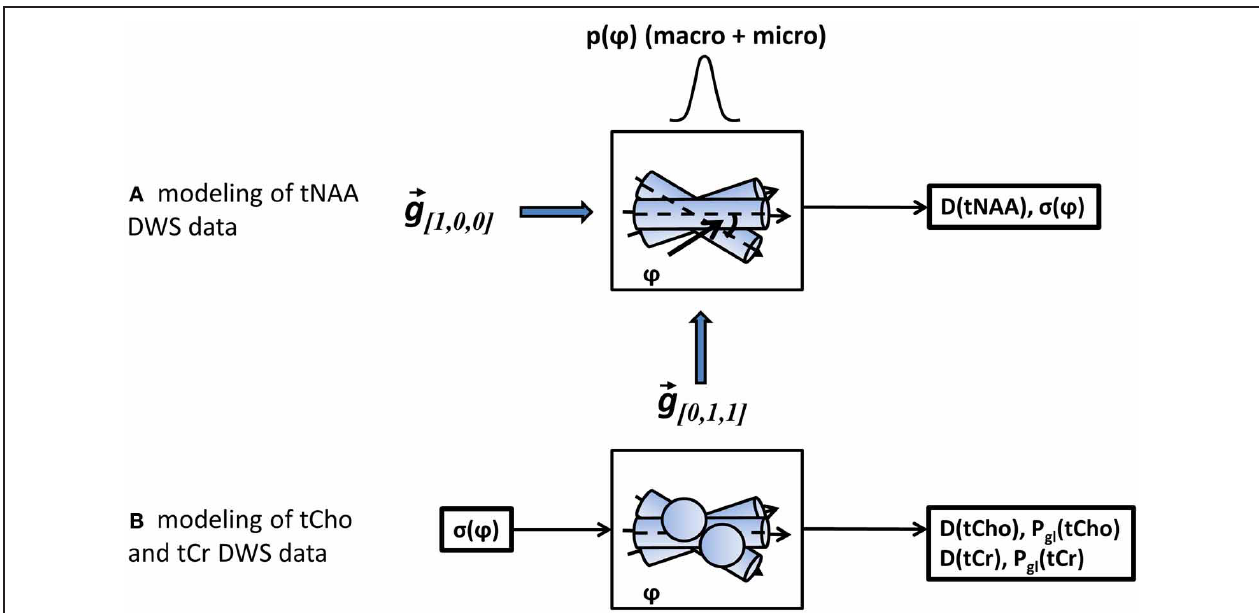
FIGURE 3 | A schematic representation of the modeling steps. In step (A) the tNAA DWS data in both diffusion-weighting directions is fitted to a model of diffusion in a set of misaligned cylinders with a gaussian angular distribution with standard deviation σ ψ . The fitting variables are the diffusion coefficient of tNAA and σ ψ . In step (B) , the DWS signal of the two non-axonal